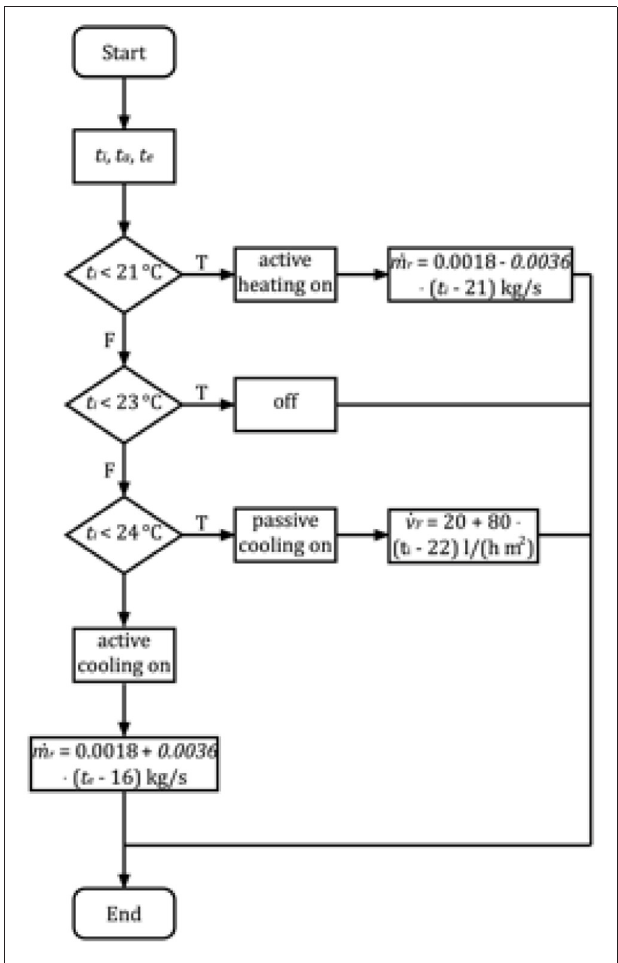
FIGURE 8 | Steady-state calculation results of performance indicators for liquid-integrated triple IGU glazings.